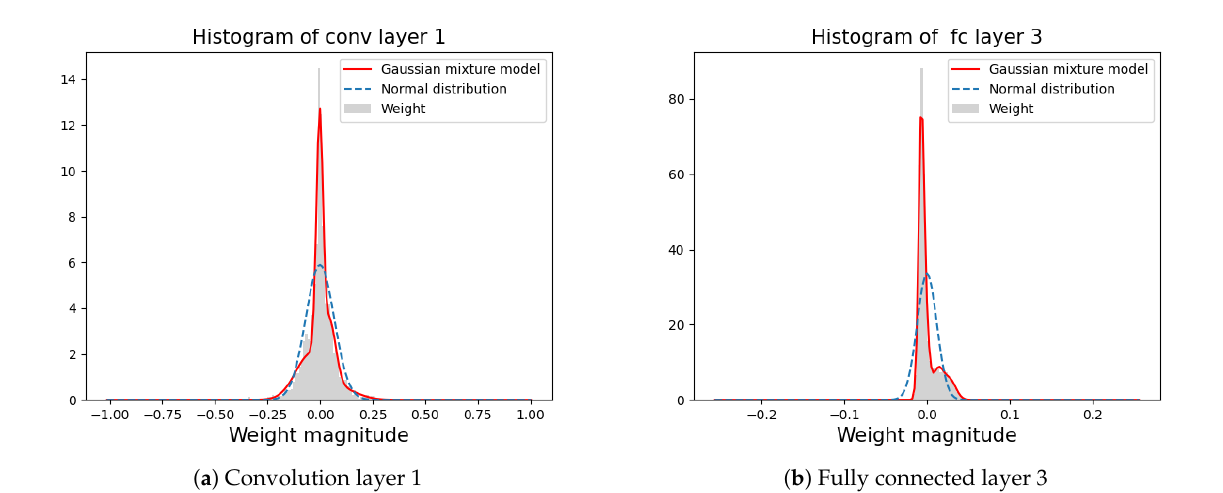
Figure 2. Modeling the weight of convolution layer 1 and fully connected layer 3 using Gaussian mixture model (GMM) and Normal distribution: ( a ) shows that GMM modeling is better than Normal distribution in terms of sharpness at 0. And, when using GMM, we can also model the complex weight shape, as shown in ( b